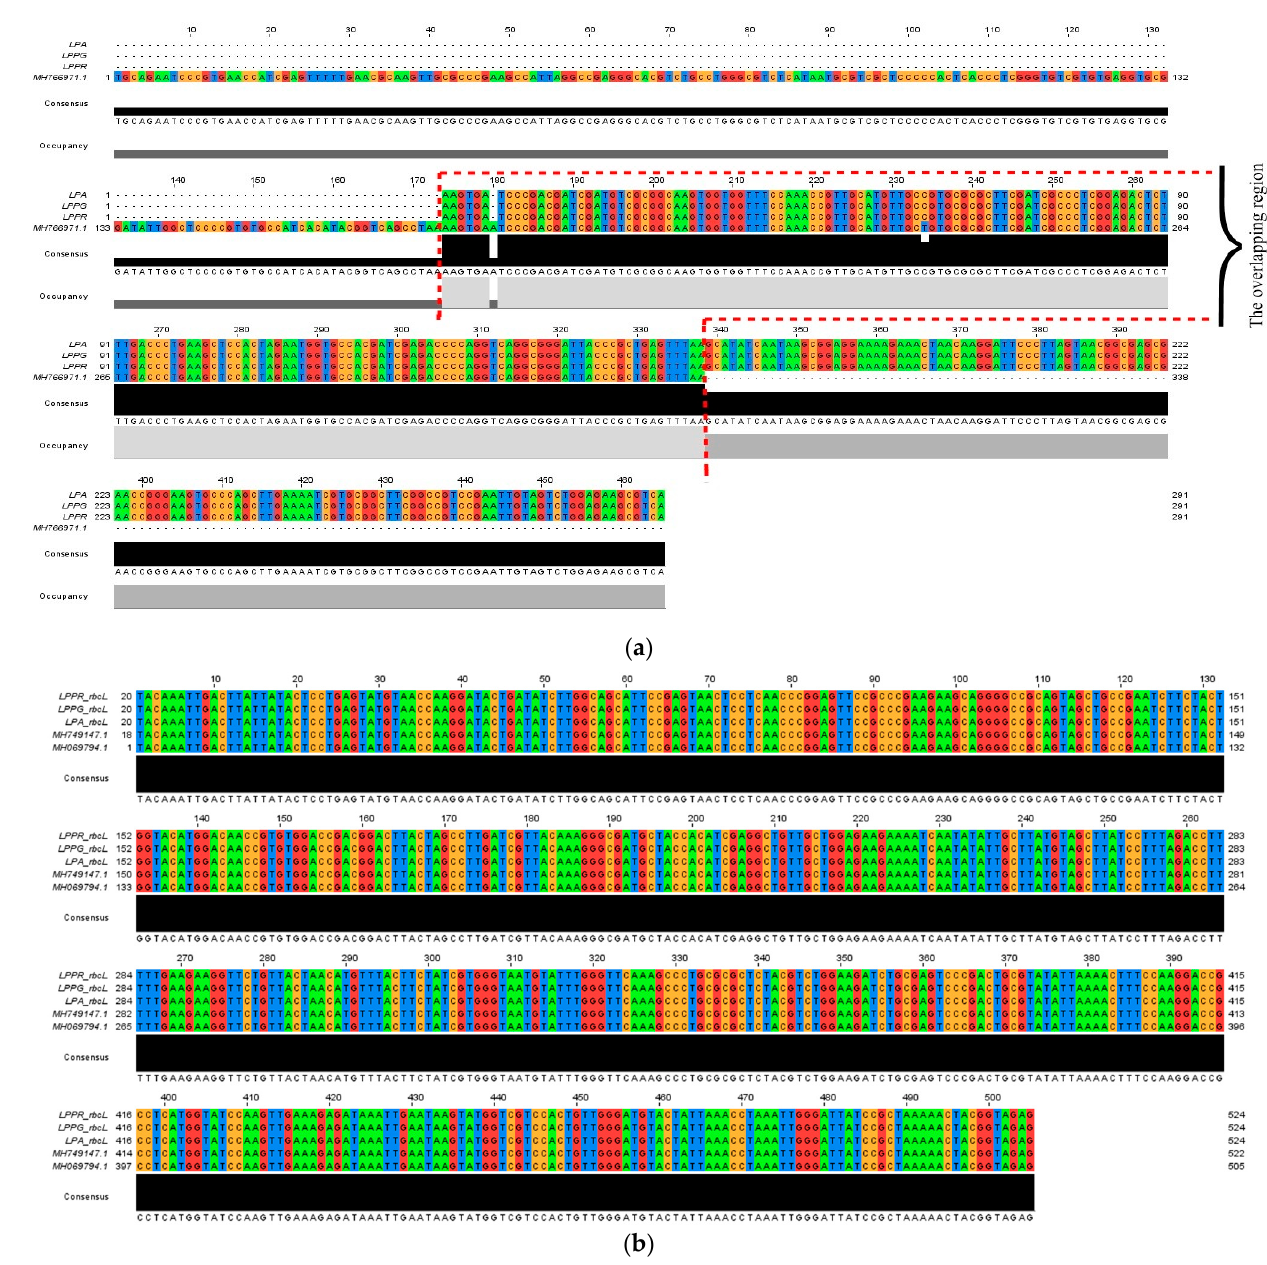
Figure 1. ( a ) Multiple sequence alignment of ITS2 gene (291 bp) from Labisia pumila leaves (var. pumila green leaf (LPPG), var. pumila red leaf (LPPR), and var. alata (LPA)) with L. pumila var. lanceolata (MH766971.1) (338 bp) aligned using Jalview software. The conserved region shows nucleotides overlapping at base 175 until 339 (164 bp). The nucleotides are coded according to color; A: adenine (green), T: thymine (blue), G: guanine (red), C: cytosine (yellow). ( b ) Multiple sequence alignment of rbc L gene (523 bp) from L. pumila leaves (LPPG_ rbc L, LPPR_ rbc L, and LPA_ rbc L) with rbc L sequences of L. pumila var. lanceolata (MH749147.1) and L. pumila (MH069794.1) previously generated by Tnah et al., 2019 [35] and Zuniga et al., 2017 [23] aligned using Jalview software. The nucleotides are coded according to color; A: adenine (green), T: thymine (blue), G: guanine (red), C: cytosine